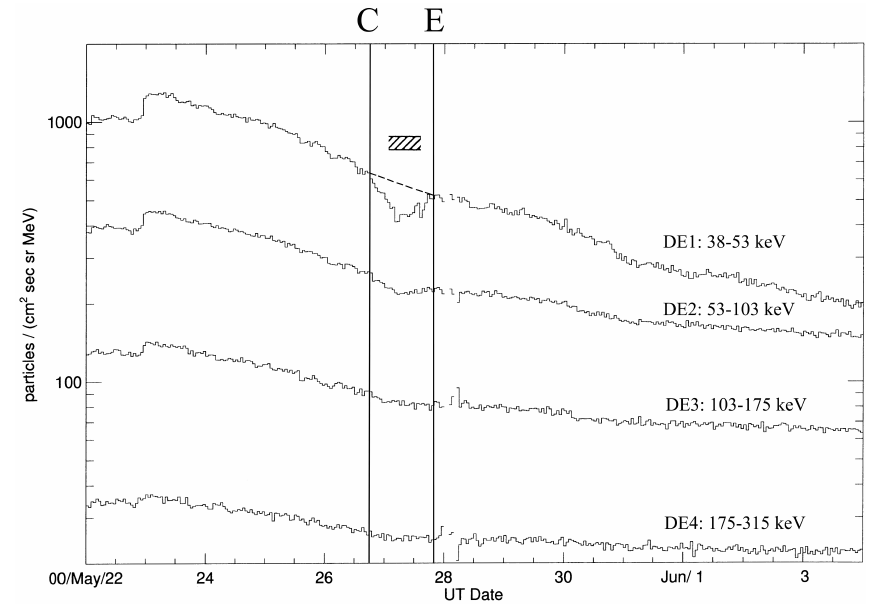
Fig. 2. Vertical traces C and E denote the commencement and end of an ICME observed by ULYSSES at 56 ◦ south heliolatitude during the solar maximum southern high-latitude